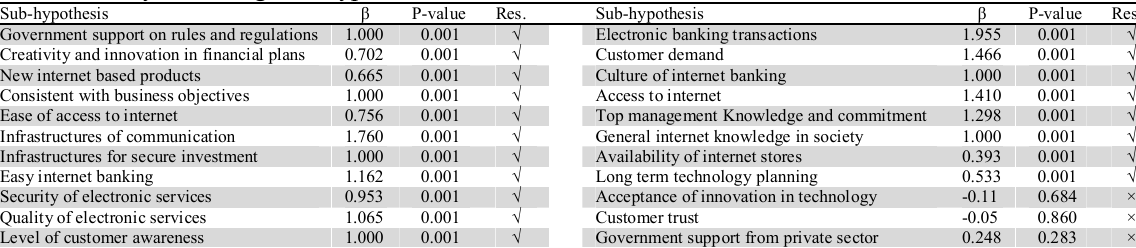
The summary of testing sub-hypotheses Sub-hypothesis Res. Government support on rules and